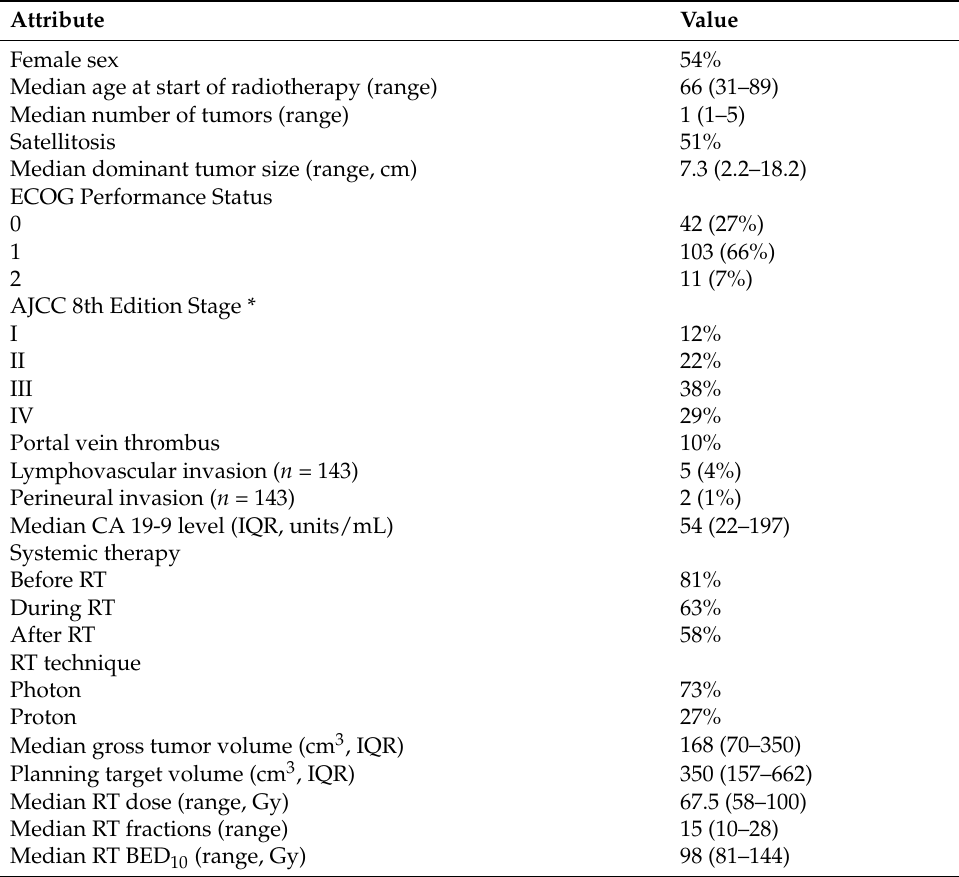
Table 1. Baseline patient, disease, and treatment